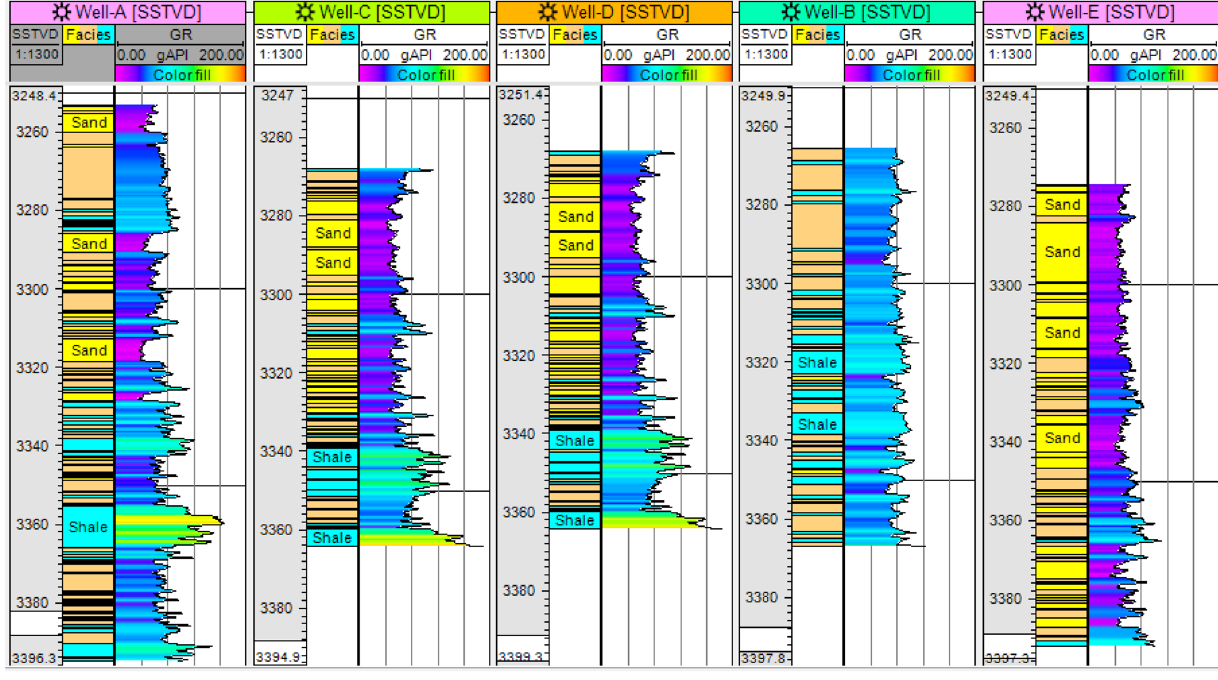
Fig. 10 Well correlation of the studied